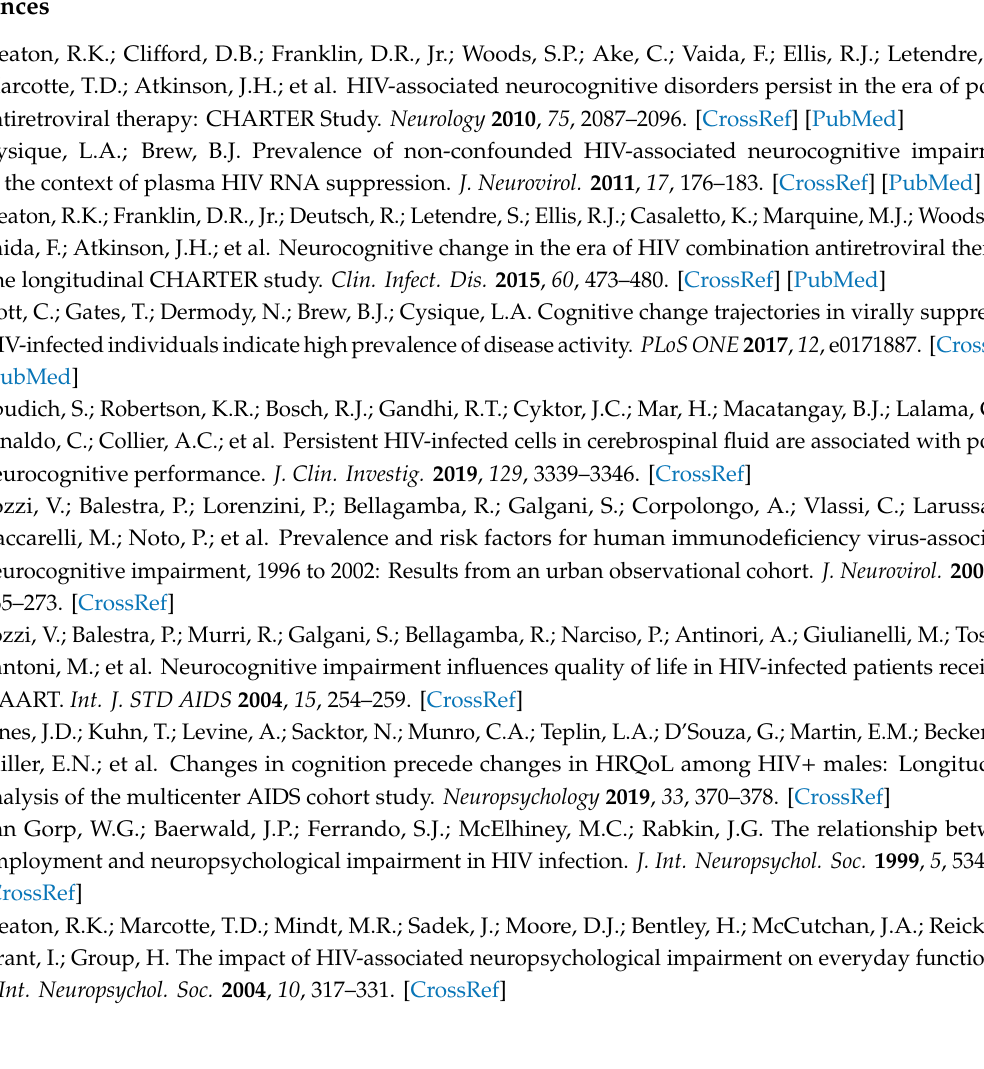
Figure S1. Representative LC3-II Western blot with corresponding total protein stain for comparison of the two normalization approaches for LC3-II. Figure S2: Comparison of APG biogenesis and degradation fold changes after 24 h or 7 day treatment with Nef and / or ART. Figure S3. Comparison of p62-II level, degradation rate, and degradation amount after 24 h or 7 days treatment with Nef and / or